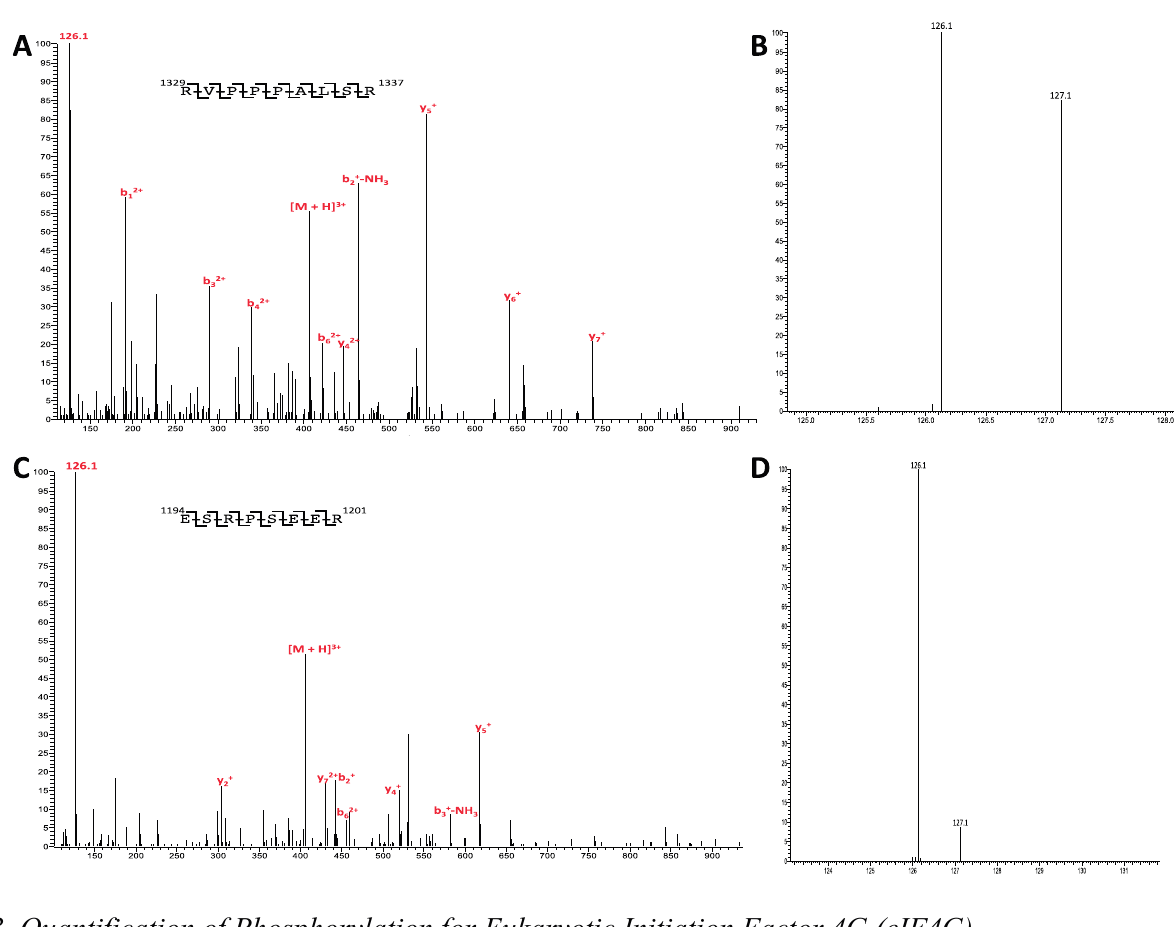
Figure 2. Quantification of phosphorylation on eIF3. ( A ) MS/MS spectra of m / z ion 406.6, z = 3. Peptide spans residues 1329–1337 for eIF3a; ( B ) Zoomed in view of the m / z region containing the TMT reporter ions. Calculation of the reporter ion ratio reveals a phosphorylation level of 18% for Ser-1336; ( C ) MS/MS spectra of m / z ion 405.5, z = 3. Peptide spans residues 1194–1201 for eIF3a; and ( D ) Zoomed in view of the m / z region containing the TMT reporter ions. Calculation of the reporter ion ratio reveals a phosphorylation level of 92% for